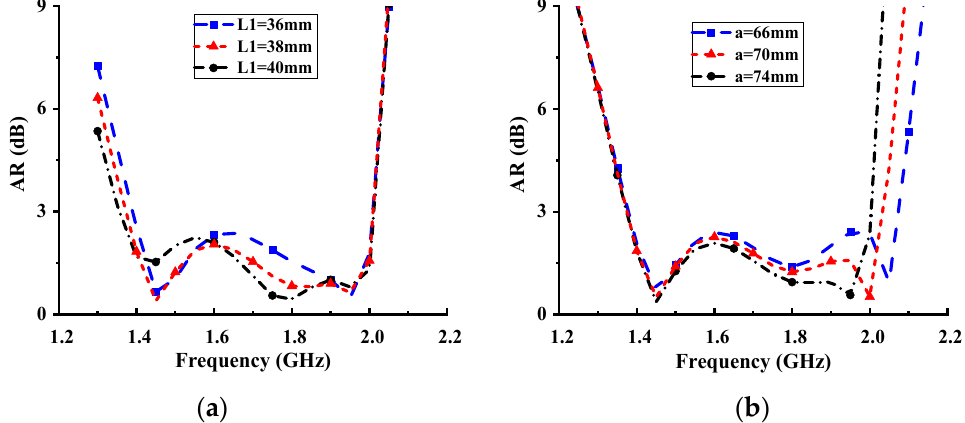
Figure 4. Simulated ARs for different length of ( a ) the cross slot. ( b ) the inverted L-shaped metals. To investigate the mechanism of the radiation null of the proposed filtering antenna, a parametric study is performed. As shown in Figure 5a, with increasing the length of the C-shaped strip, the lower radiation null is shifted to the lower frequency, while the upper radiation null remains unchanged. The influence of the U-shaped slot etched on the feedline is studied, as shown in the Figure 5b, with increasing the length of the strip, the upper radiation null is shifted to the lower frequency, while the lower null is not affected.